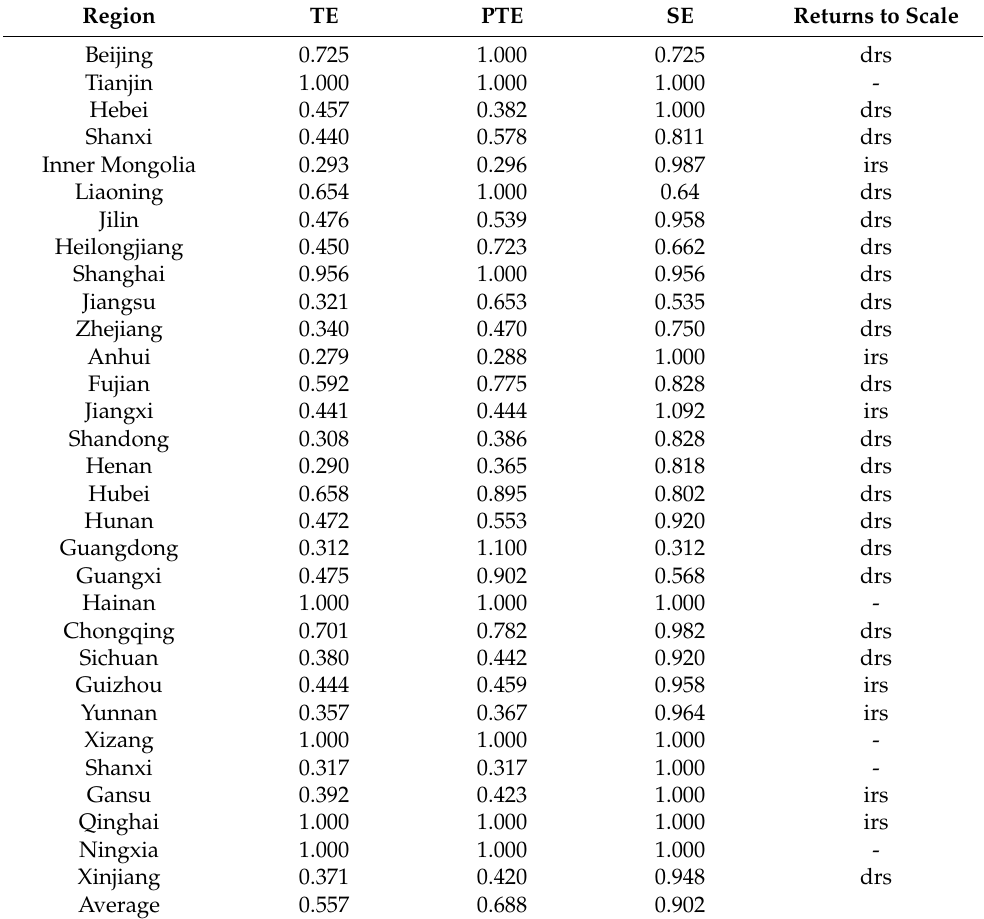
Table A1. The first-stage technical efficiency and scale efficiency of provincial public sports service.